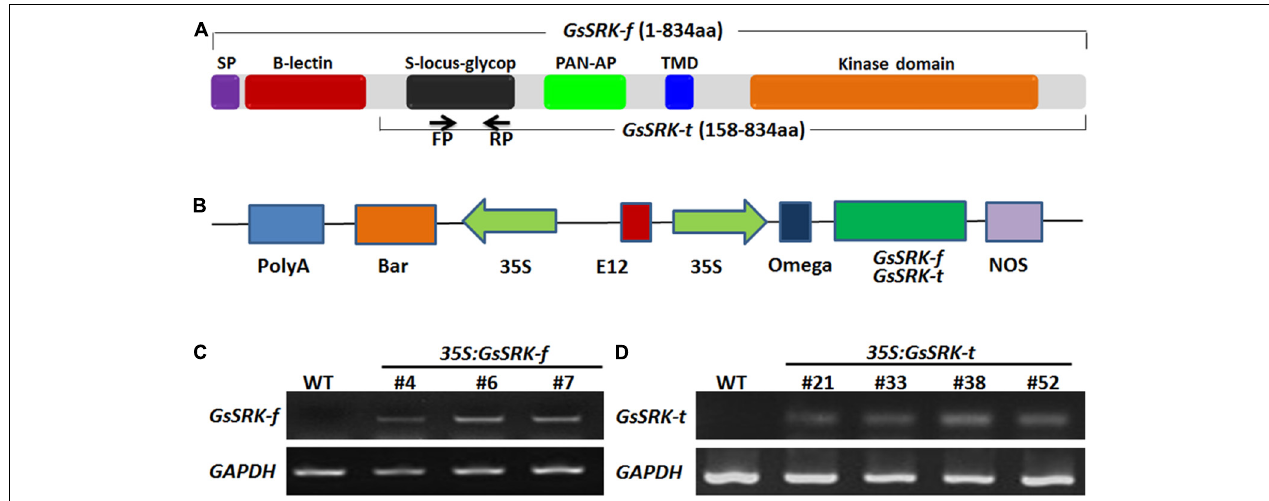
FIGURE 2 | Generation of GsSRK-f and GsSRK-t transgenic alfalfa. (A) Structures showing the conserved domains of GsSRK-f and GsSRK-t . The arrows labeled with FP and RP indicated the positions of the primers used for semi-quantitative RT-PCR analysis. (B) Structures showing the constructs for GsSRK-f and GsSRK-t overexpression in alfalfa. Construct for GsSRK-f overexpression contains the full-length GsSRK gene, while construct for GsSRK-t overexpression contains a truncated version of GsSRK-f , without the N-terminal signal peptide and G-type lectin domain. (C) Semi-quantitative RT-PCR identification of GsSRK-f transgenic lines. (D) Semi-quantitative RT-PCR identification of GsSRK-t transgenic lines. The GAPDH gene in alfalfa (Accession No.: Medtr3g085850) was used as an internal control.